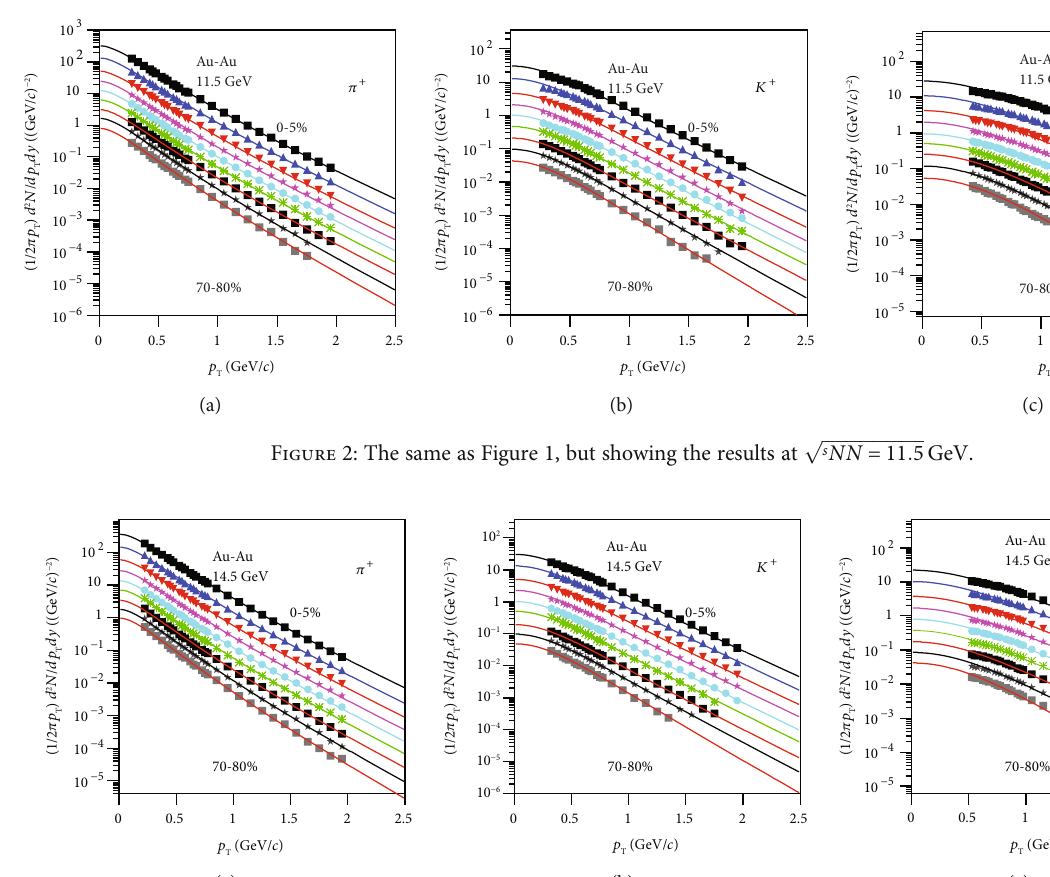
ffiffiffiffiffiffiffiffiffi p = 14 : 5GeV , where the data are cited from Ref. [20]. s NN